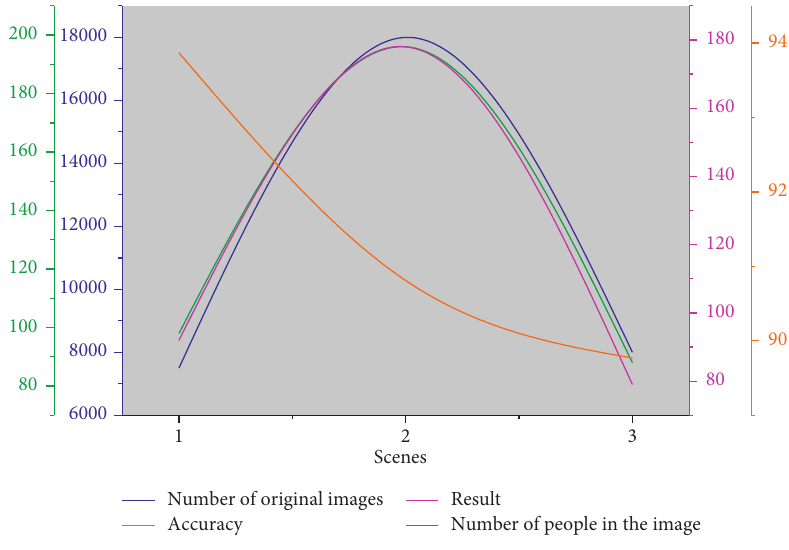
Figure 12: Detection results of the three